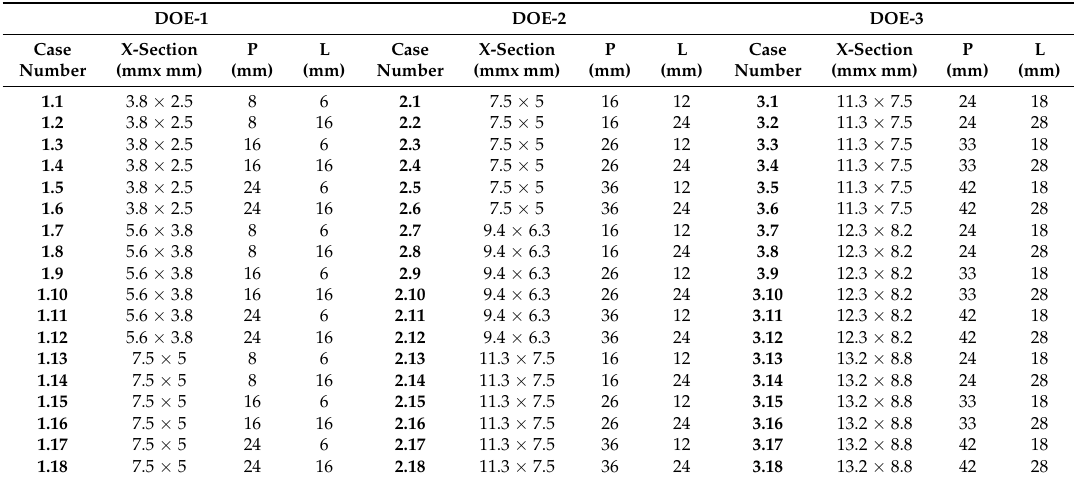
Table 2. Case setup variables in design of experiments (DOEs) 1, 2 and 3, in which the thickness of the plastic parts are set at one mm, 3.5 mm, and six mm,